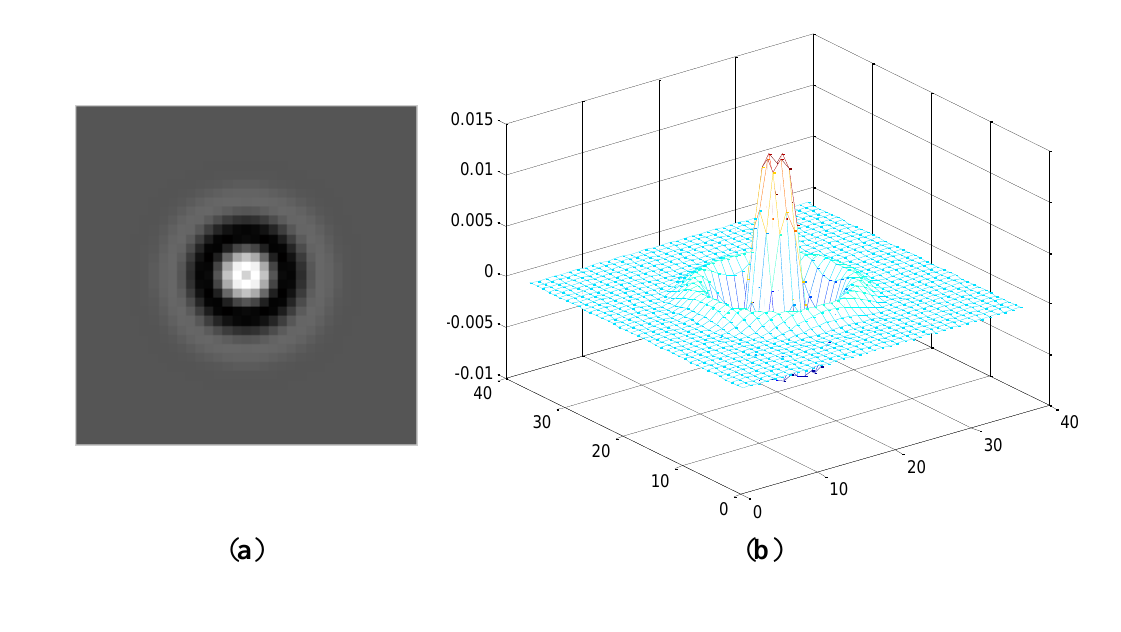
( x , y ) − Z ( x , y ) i r i